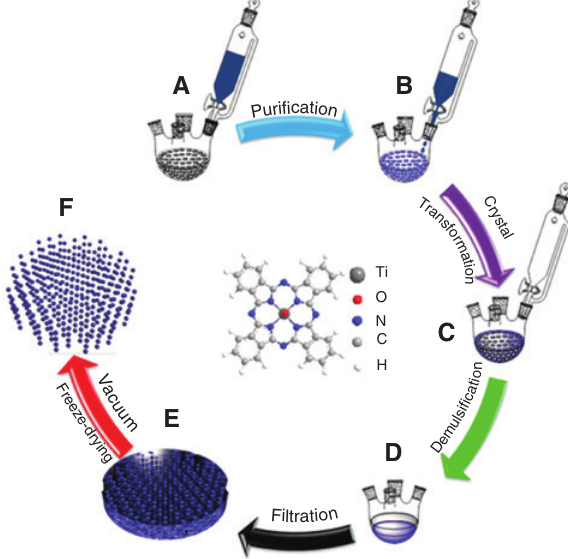
Figure 1: The schematic of the microemulsion phase transfer method for preparing the α - and β -TiOPc NPs, the inset is the 3D model of a TiOPc molecule. (A) H O/o-PhCl microemulsion, (B) TiOPc/H SO solution dropwise 2 2 2 4 into the H O/o-PhCl microemulsion, (C) TiOPc NPs transfer into 2 2 o-PhCl phase, (D) Microemulsion stratification, (E) Frozen filter 2 cake, (F) Obtaining TiOPc NPs. Figure 2(A, B) shows that the XRD patterns of the TiOPc NPs obtained at 288 K and 338 K exhibit a typical α - type crystal form (2 θ : 7.5 ° , 25.3 ° , 28.6 ° ), and β -type crystal form (2 θ : 9.2 ° , 10.4 ° , 26.2 ° ), respectively [45, 46]. As shown